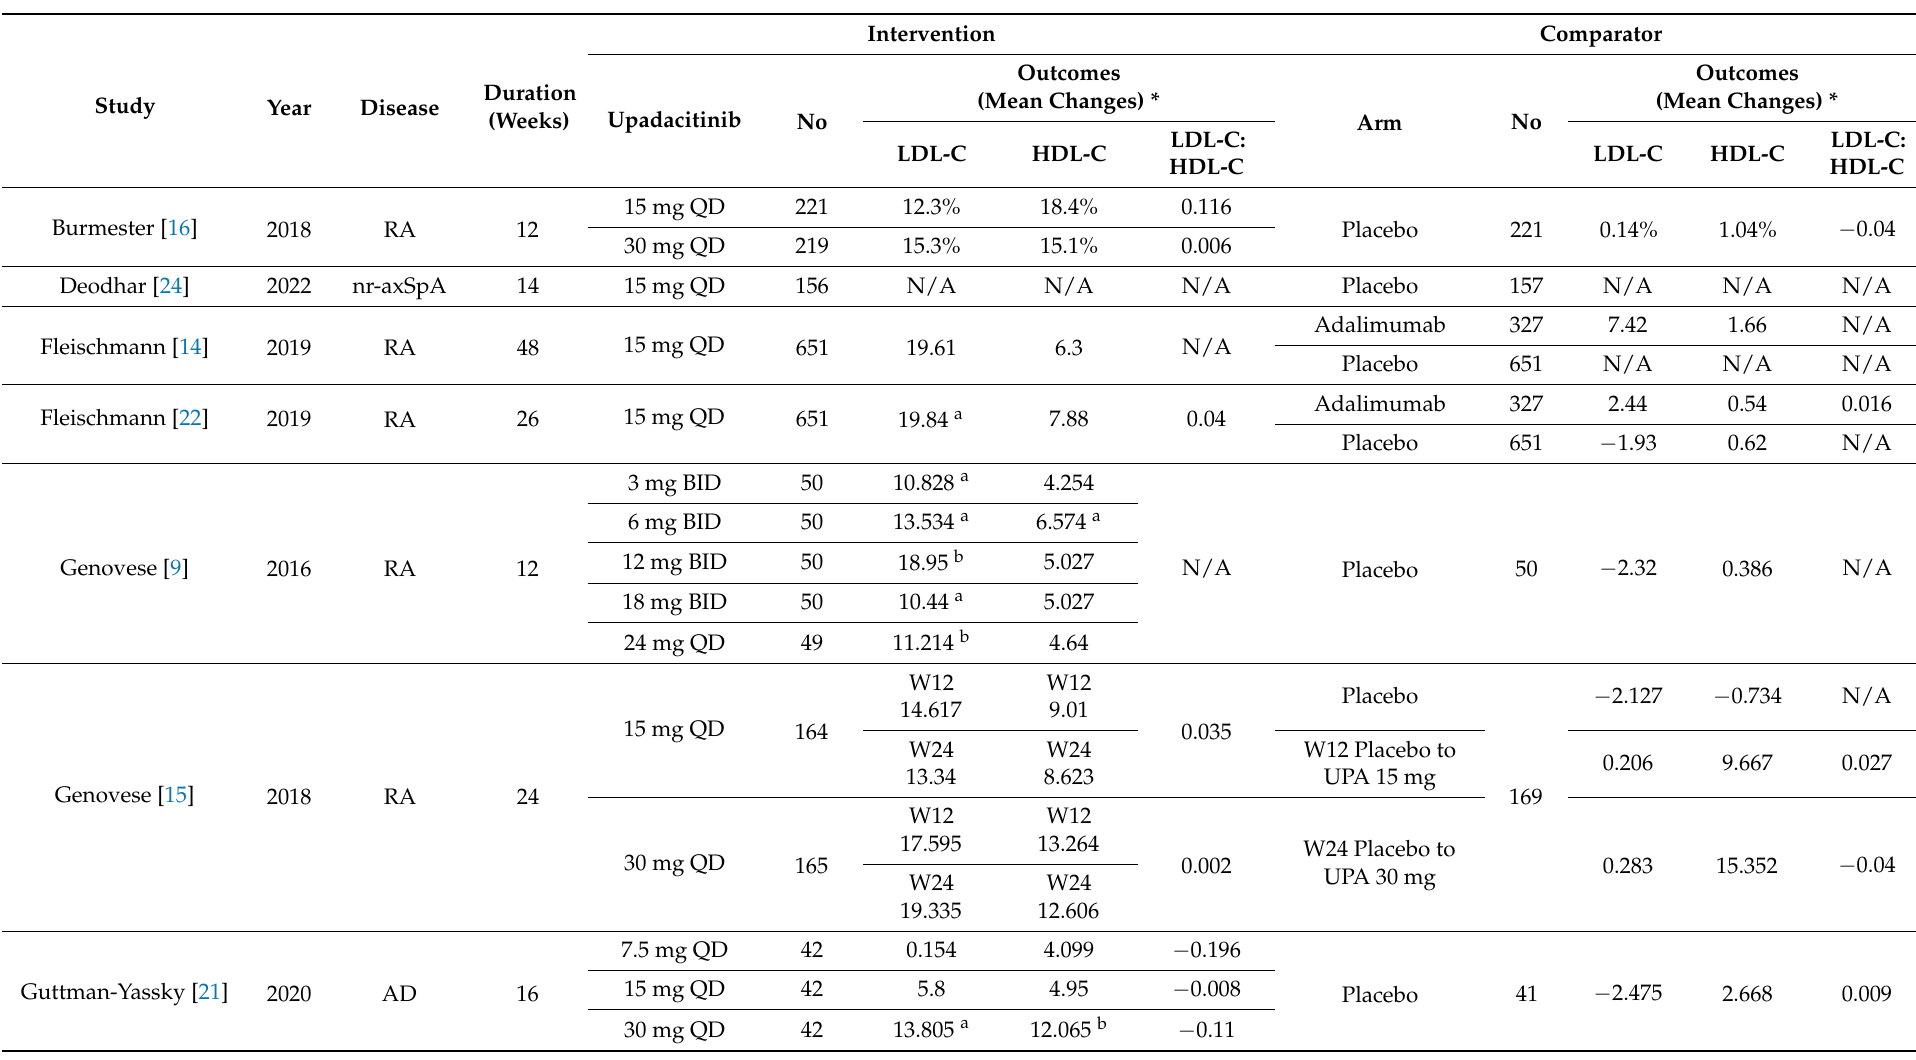
Table 2. Effects of upadacitinib on LDL-C and HDL-C in the eligible